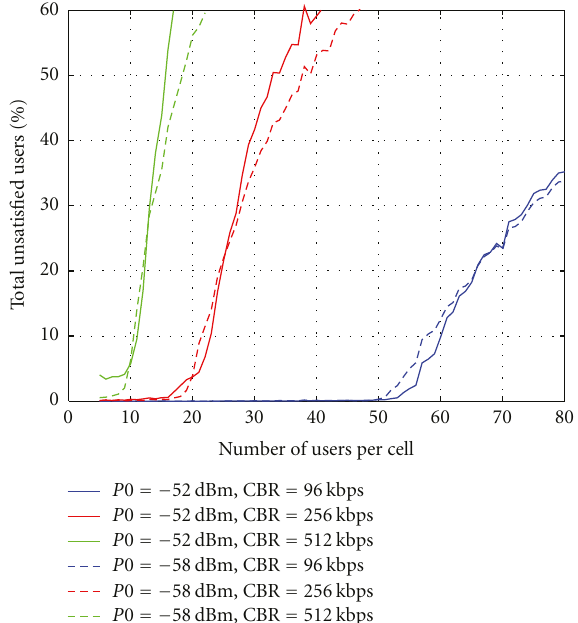
Figure 6: Total number of unsatisfied users.